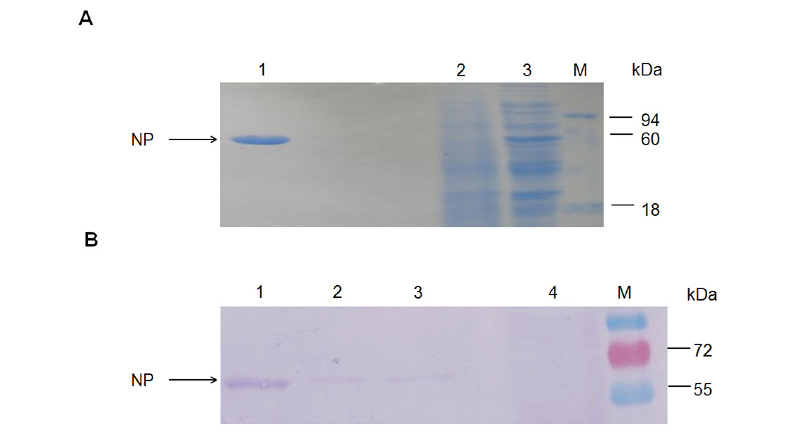
Figure 2. SDS-PAGE and western blot analysis of purified full-length NP protein expressed in Escherichia coli. (A) SDS-PAGE and Coomassie staining. Lane 1: purified NP protein; lane 2: bacterial whole cell lysate without IPTG induction; lane 3: bacterial whole-cell lysate with IPTG induction. (B) Western blot analysis. Purified NP protein and uninduced bacterial whole-cell lysate were detected with 1:5,000 diluted mouse anti-His tag mono- clonal antibodies (Sigma) and 1:30,000 diluted goat-anti mouse Abs-conjugated to alka- line phosphatase (Sigma). Lanes 1, 2, 3: purified NP protein; lane 4: bacterial whole-cell extract without IPTG induction.